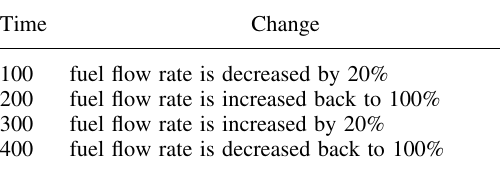
Table 3. Simulation details for fuel flow